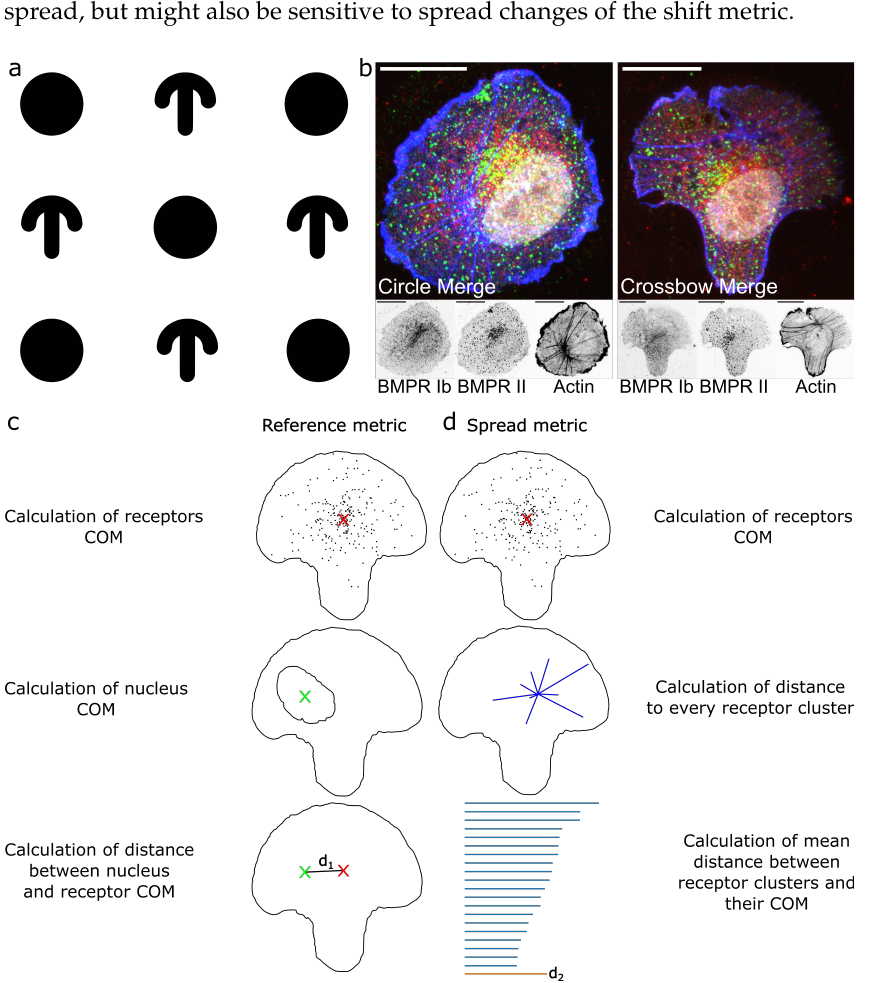
Figure 1. Outline of experiments and mode of operation of ComRed. ( a ): Scheme of circle and cross- bow pattern. White background is passivated with PLL-PEG, while black regions are micropatterned using a photomask in a UV-ozone cleaner and coated with fibronectin (Section 4.1). Circle diameter is 50 µm. ( b ): examples of confocal microscopy images of HUVECs seeded on a circle (left) and crossbow micropattern (right). Green: BMPRIb, Red: BMPRII, Blue: actin, White: nucleus. Scale bars in all confocal images are 20 µm. ( c , d ): steps for the calculation of reference and spread metrics. For both metrics, first the center of mass of a receptor distribution is calculated. ( c ): For the reference metric, a reference point is taken, e.g., the center of mass of the nucleus. Afterwards, the distance between the two center of mass points is calculated. ( d ): For the spread metric, after determination of the center of mass of the receptor distribution, the distance to each single accumulation is calculated and the mean of these distances is